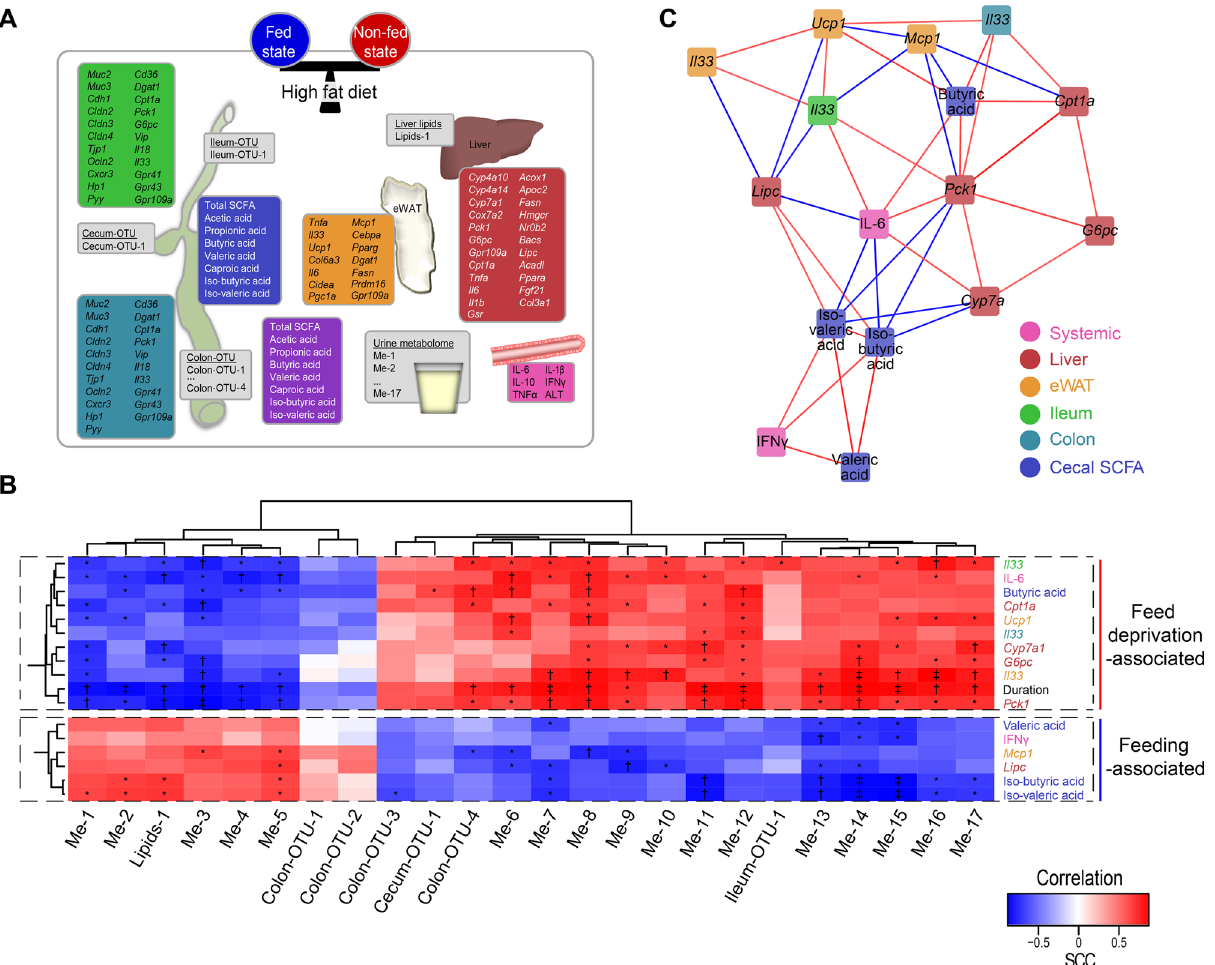
Figure 1. Integration of host parameters and bacterial fermentation products with feed deprivation-induced gut microbiota, liver lipids, and urine metabolite clusters. ( A ) Metabolic and inflammatory host response parameters, gut microbiota, and intestinal fermentation products determined in fed (n = 10) and feed deprived (n = 9) high-fat diet-induced obese mice. The coloring of boxes relates to measured specific factors: gene expression in liver (dark red), epididymal white adipose tissue (eWAT, orange), ileum (green) and colon (turquoise), plasma-derived cytokines and alanine aminotransferase (ALT) (pink), short-chain fatty acids from cecum (blue) and feces (purple). Feed deprivation-associated lipid species cluster, which is based on determined liver triglyceride and phospholipid species (Lipids-1), the 17 urine metabolite clusters (Me-1 to Me-17) and OTU clusters from the ileal, cecal and colonic compartments (Ileum-OTU-1, Cecum-OTU-1, Colon-OTU-1 through Colon-OTU-4) are shown in grey boxes. ( B ) Correlation heat map of the hierarchically clustered z-score-normalized low complexity parameters (y-axis) against the computed eigenvectors of lipid, metabolite and OTU clusters (x-axis) associated with feed deprivation. The duration of feed deprivation is included as a host parameter (span between 8 h and 16 min to 11 h and 32 min). The heat map color represents Spearman rank correlation coefficients (SCC), as visualized in the insert, and asterisks mark FDR-adjusted significant correlations (*, FDR < 0.05; †, FDR < 0.01; ‡, FDR < 0.001). ( C ) Network showing the internal relationship among host parameters associated with feed deprivation for edges with significant SCC (red: SCC > 0.6, blue: rho < − 0.6, FDR < 0.05). Node colors indicate the tissue origin of the individual variable, as indicated in the